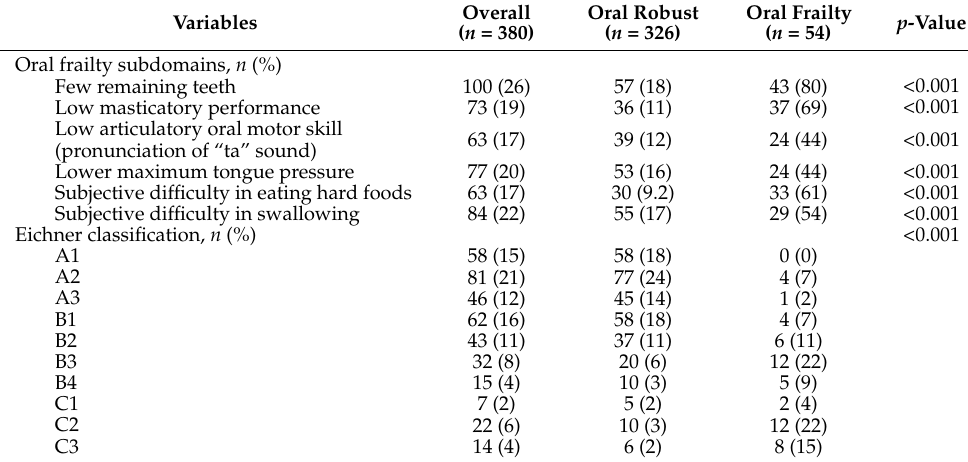
Table 2. Distribution of participants per oral functions and statuses.